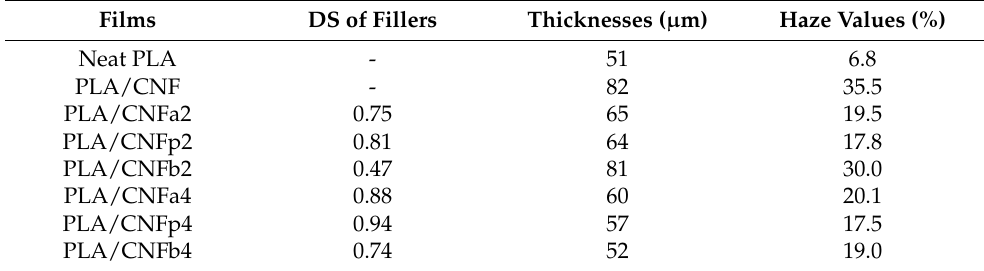
Table 3. Average thicknesses and haze values of the PLA/m-CNF composite